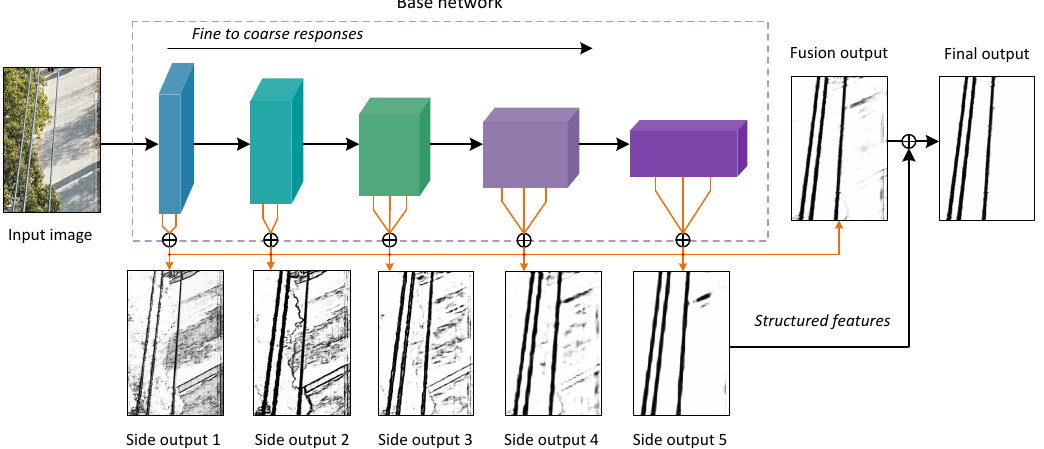
Figure 1. The structure of our power line detection network. The side outputs are generated by combining all the convolutional feature maps in each stage, which become coarser as the stride becomes larger. Exploiting the structured features, the final output presents excellent